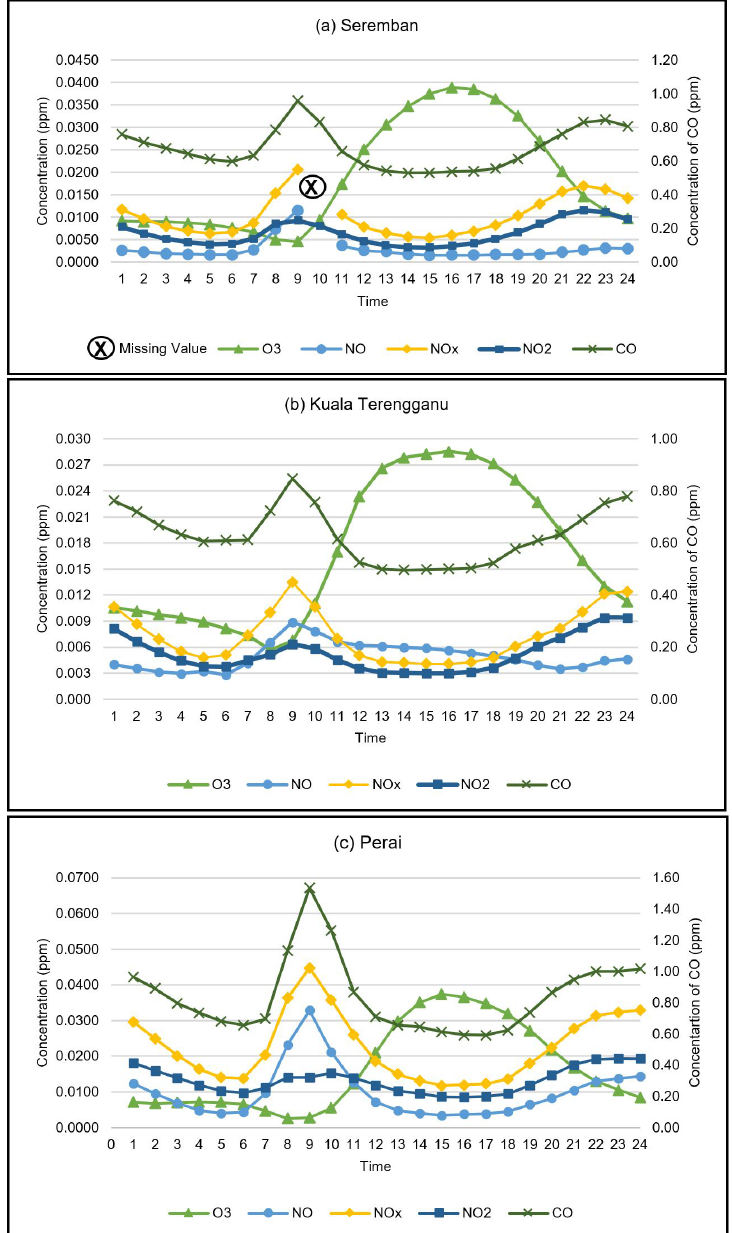
Figure 5. Diurnal plot of O 3 precursors in ( a ) Seremban, ( b ) Kuala Terengganu, and ( c ) Perai.